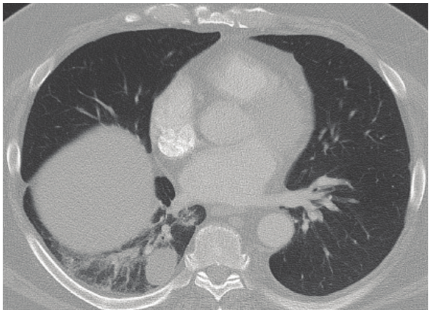
Figure 3: Axial image of CT of chest performed on April 15, 2015; pulmonary windows demonstrate an enlarging 3.6 cm nodu- lar opacity in the right lower lobe with minimal subsegmental atelectatic changes and ground-glass opacity.